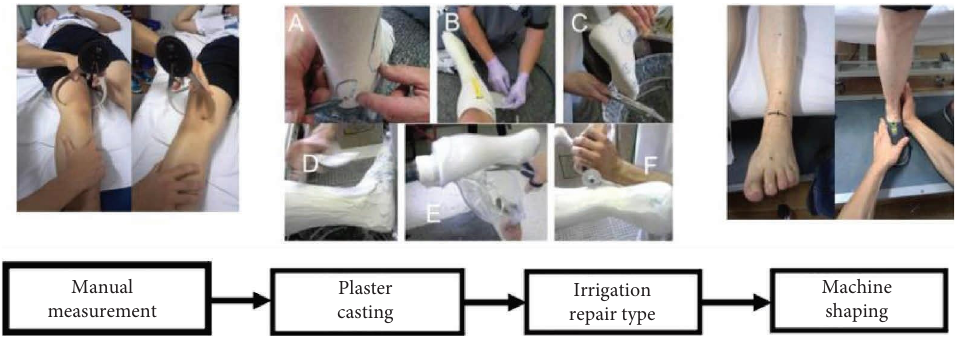
Figure 1: Manufacturing process of traditional